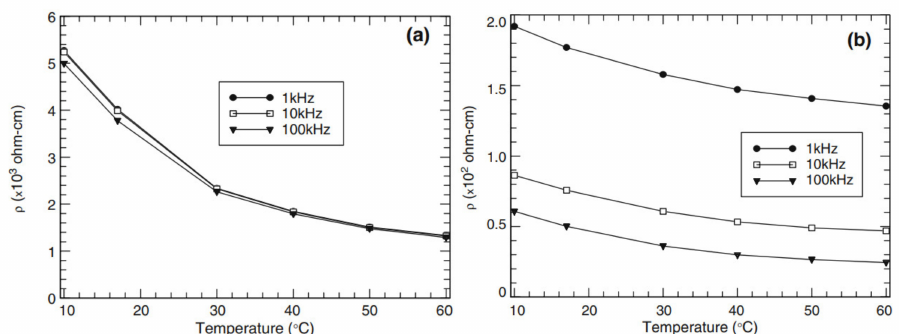
Figure 11. Variation in resistivity with temperature ( a ) plain cement mortar and ( b ) cement mortar incorporated with 3 mm carbon fibers. Reproduced with permission from [57], McCarter et al., 2007.